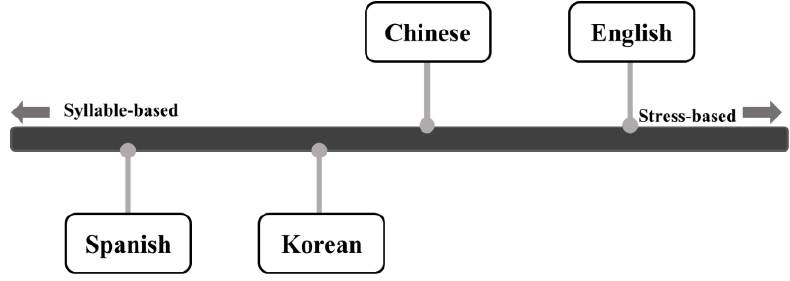
Figure 5. Language distribution property.